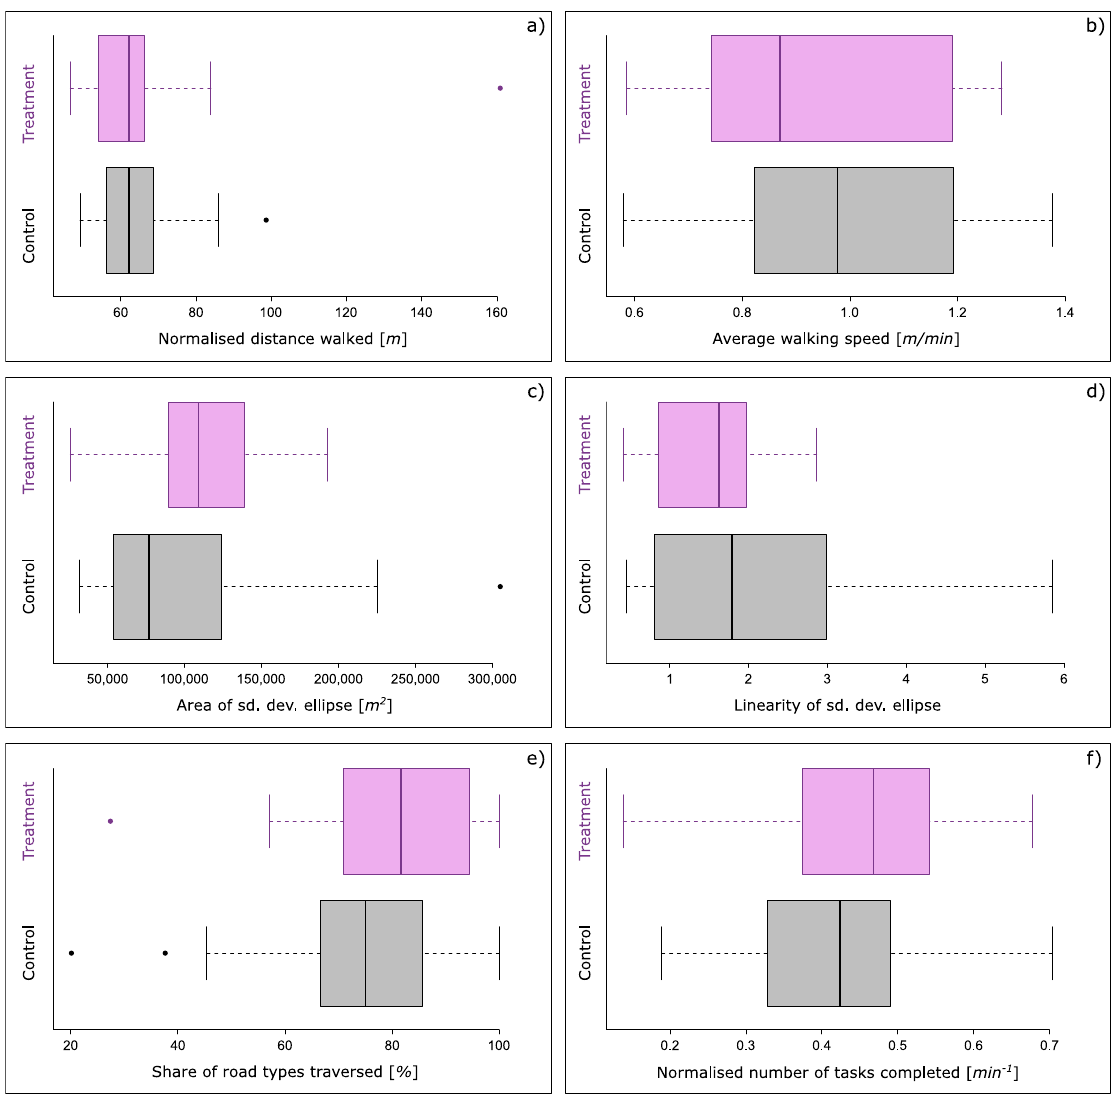
Figure A1. Box plots of behavioural variables assessed for both tested groups. ( a ) Normalised distance walked; ( b ) Average walking speed; ( c ) Area of the standard deviational ellipse; ( d ) Linearity of the standard deviational ellipse; ( e ) Share of road types traversed; ( f ) Normalised number of tasks